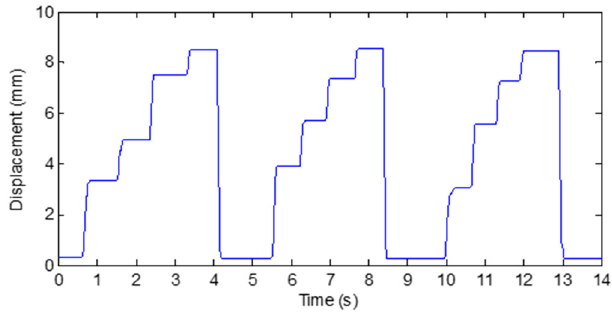
Figure 14. Results of Test B in response testing on a human finger.